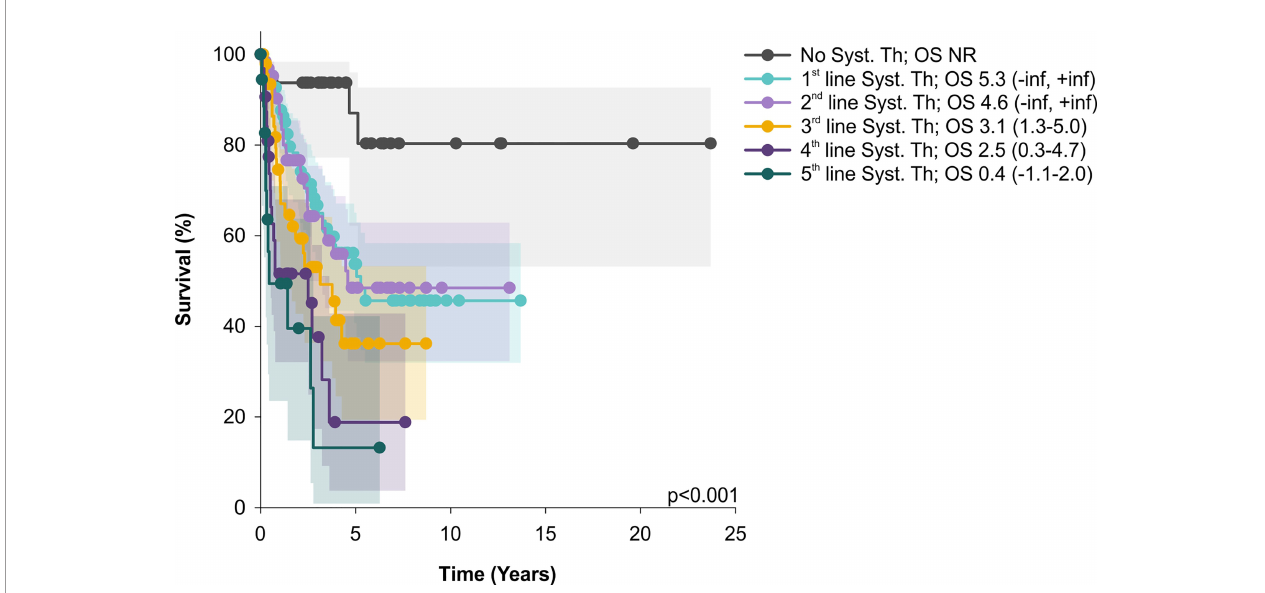
FIGURE 3 | OS of patients treated only by skin directed therapy signi fi cantly differs from those with systemic treatment (Syst. Th); similarly, OS of patients treated by 1 and 2 lines of systemic therapy was signi fi cantly better than OS of patients after 4 or 5 systemic treatment lines. Median overall survival and 95% CI are showed. OS, median overall survival; CI, con fi dence interval; NR, not